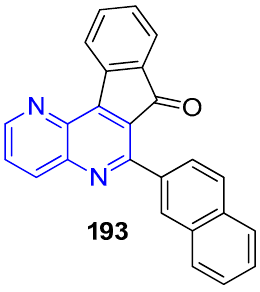
Figure 23. Fused 1,5-naphthyridine as optical DNA biosensor.